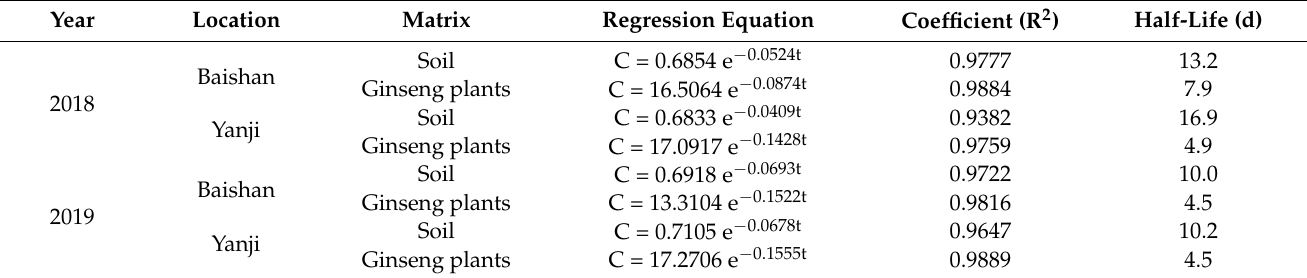
Figure 2. Degradation kinetic curve of flupyradifurone in ginseng plants and soil: ( a ) ginseng plants; ( b ) soil. Table 1. Dissipation kinetics of flupyradifurone in soil and ginseng plants.